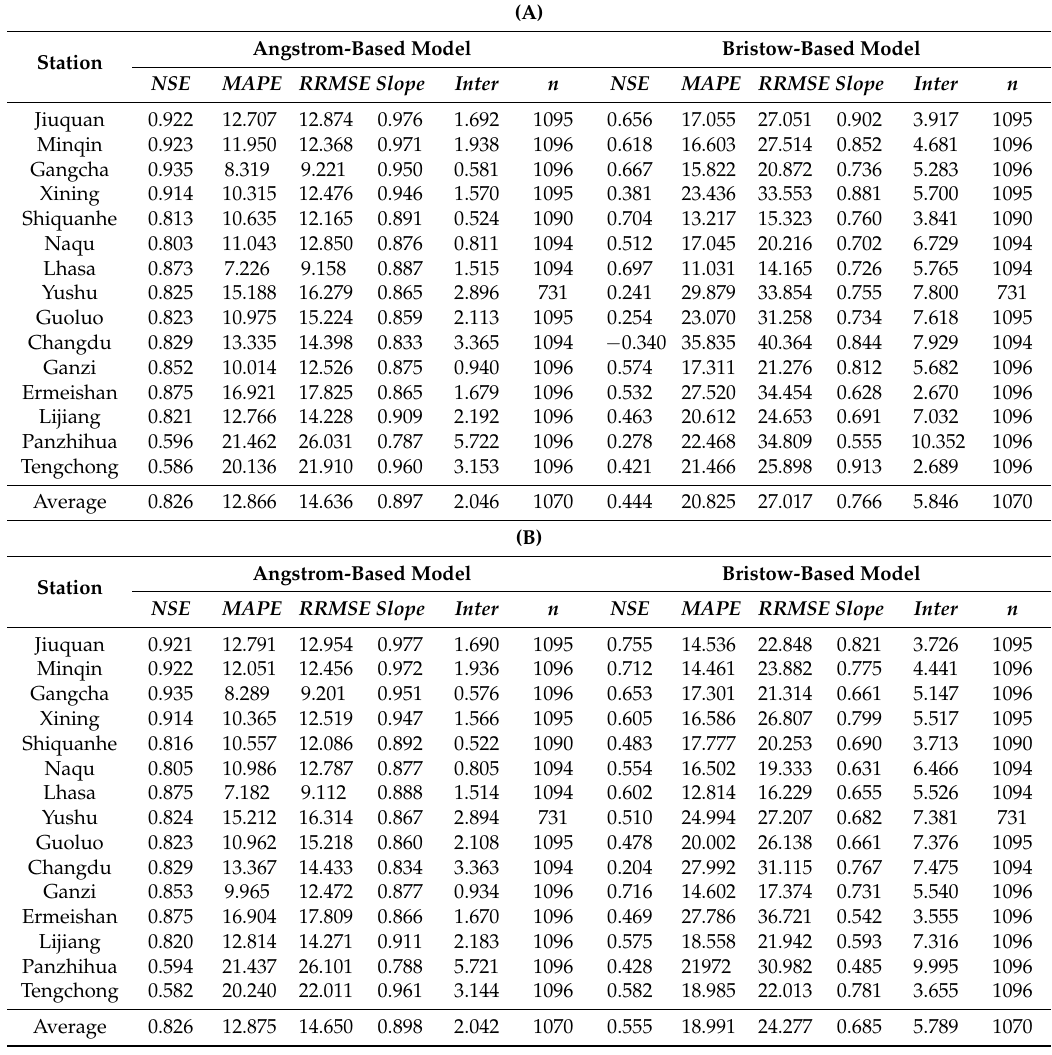
Table 3. Performance of the simple average model and the statistical average model using the validation dataset from 2008 to 2010. (A) Simple average model. Angstrom-Based model: a = 0.229, b = 0.549; Browstow-Based model: a = 0.785, b = 0.027, c = 1.617. (B) Statistical average model.